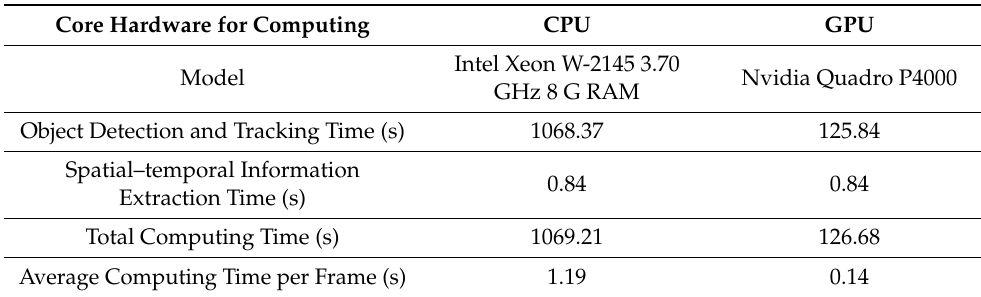
Table 4. The experimental time statistics in CPU and GPU hardware environments, respectively.